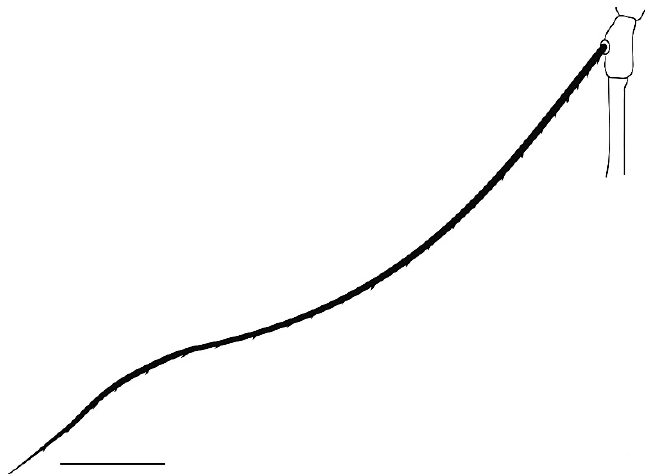
Figure 9. Neophyllobius combreticola . Female. Genu IV. Scale bar: 50 μ